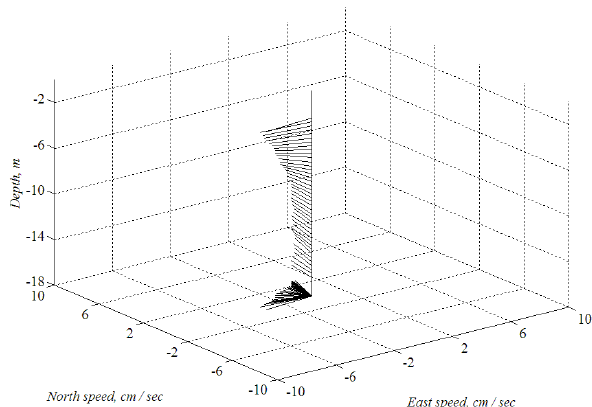
Figure 6. Fig. 6. Vertical structure of tidal ellipse amplitudes for the diurnal (K1) frequency. Units are cm/s for the east, north speed (x, y) axes, and m for the depth-axis